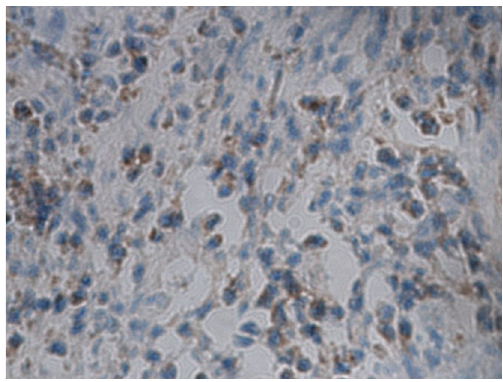
Figure 1. The VEGF level after treatment; sample U-1.